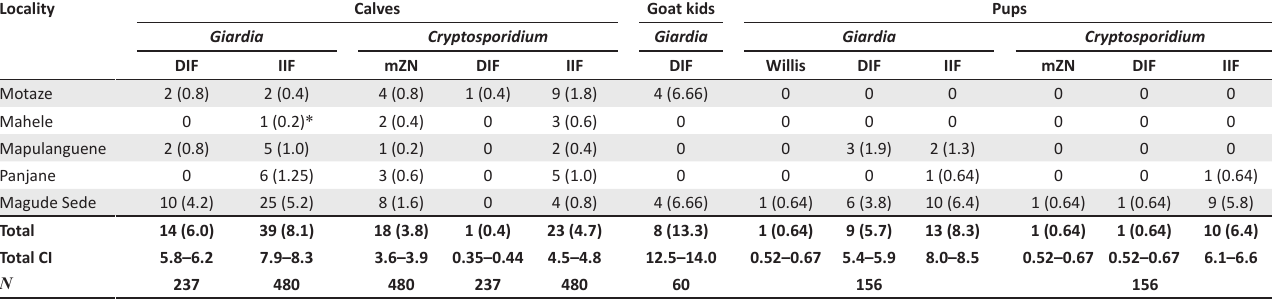
TABLE 1: Prevalence ( % ) of Giardia spp. and Cryptosporidium spp. in calves, goat kids and dog pups in different localities of the Magude District, Mozambique. Locality Calves Goat kids